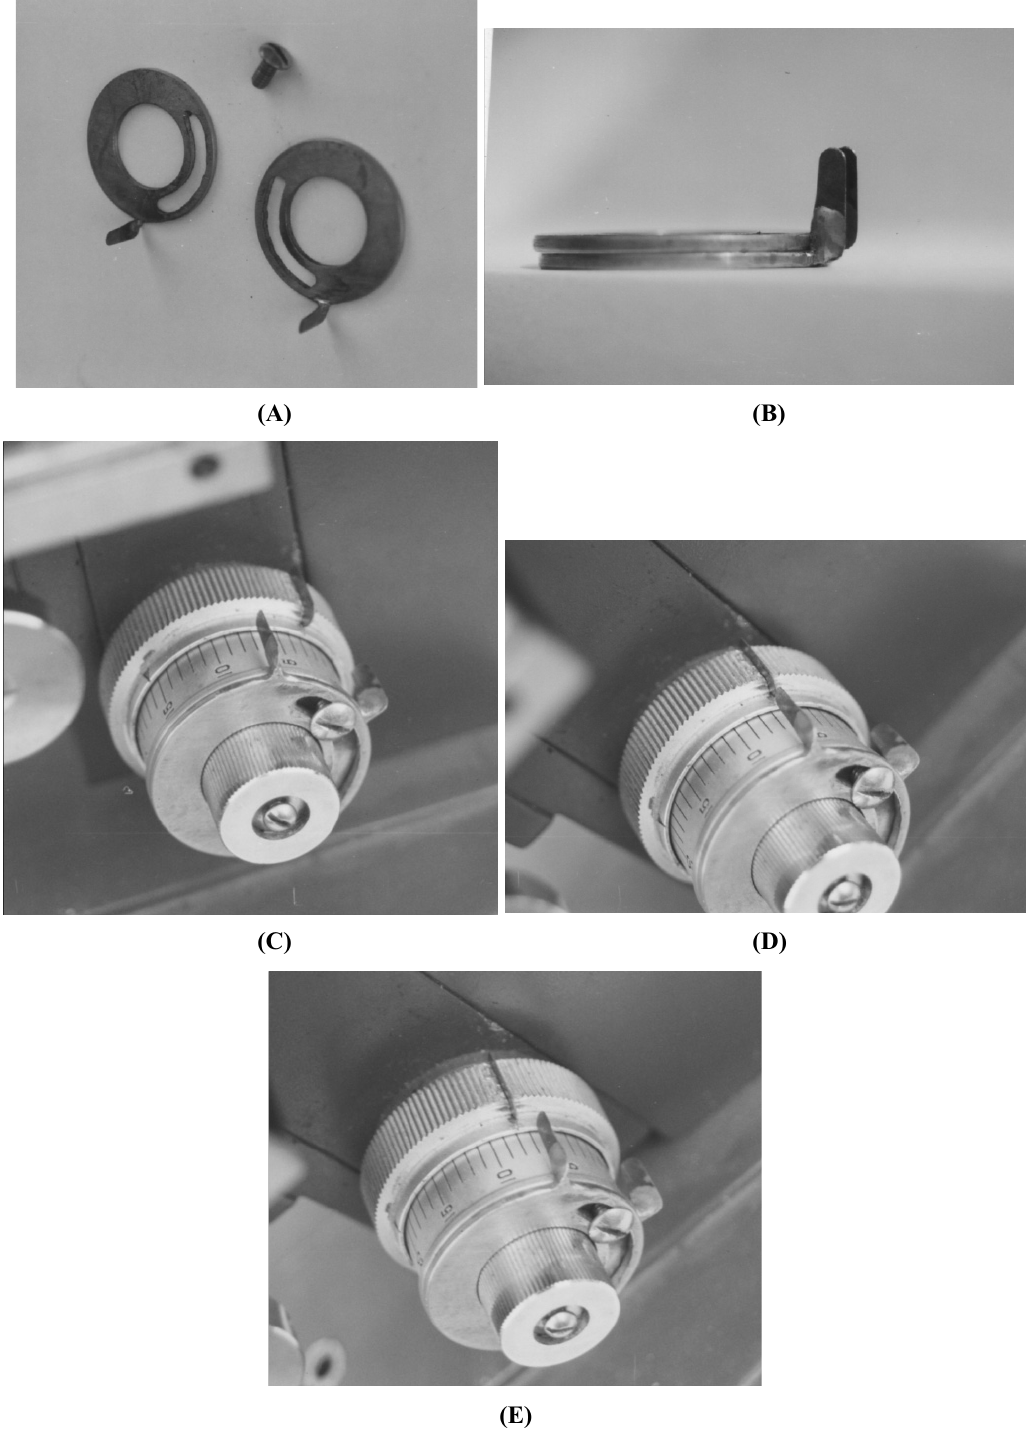
Fig. 1 – The two rings of metal with one palette welded in each ( A-E ) and the palette welded in the gross focuses ( C-E ) to restrict the route of fine focuses (Z-axis study) ( D ). Note that palettes welded in the rings, bump into the palette welded in the gross focuses, but the palettes welded in the rings can also pass by the palette welded in the gross focuses (after bump it) to better visualize the biological tissue ( D-E